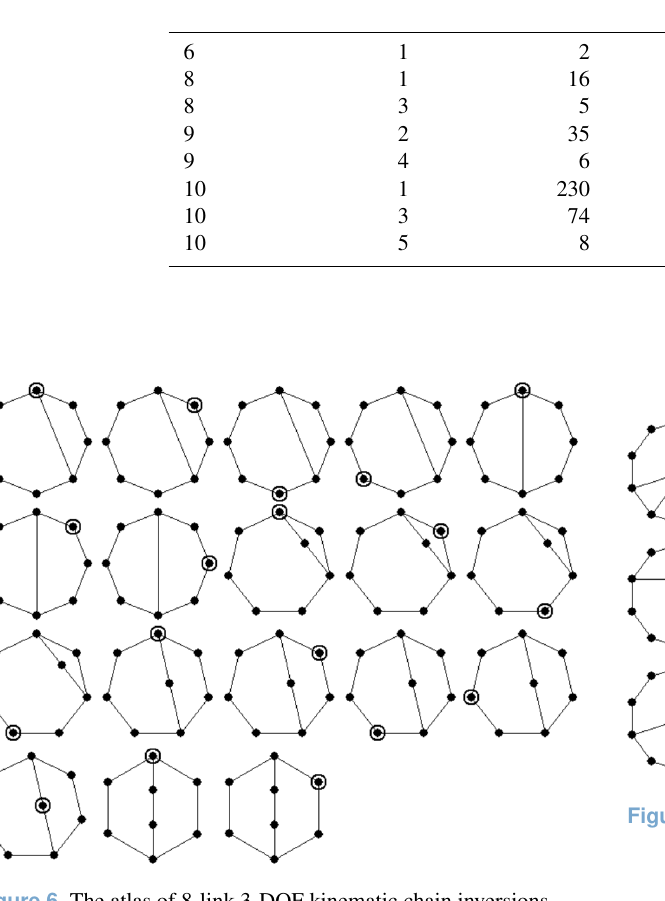
Figure 6. The atlas of 8-link 3-DOF kinematic chain inversions.